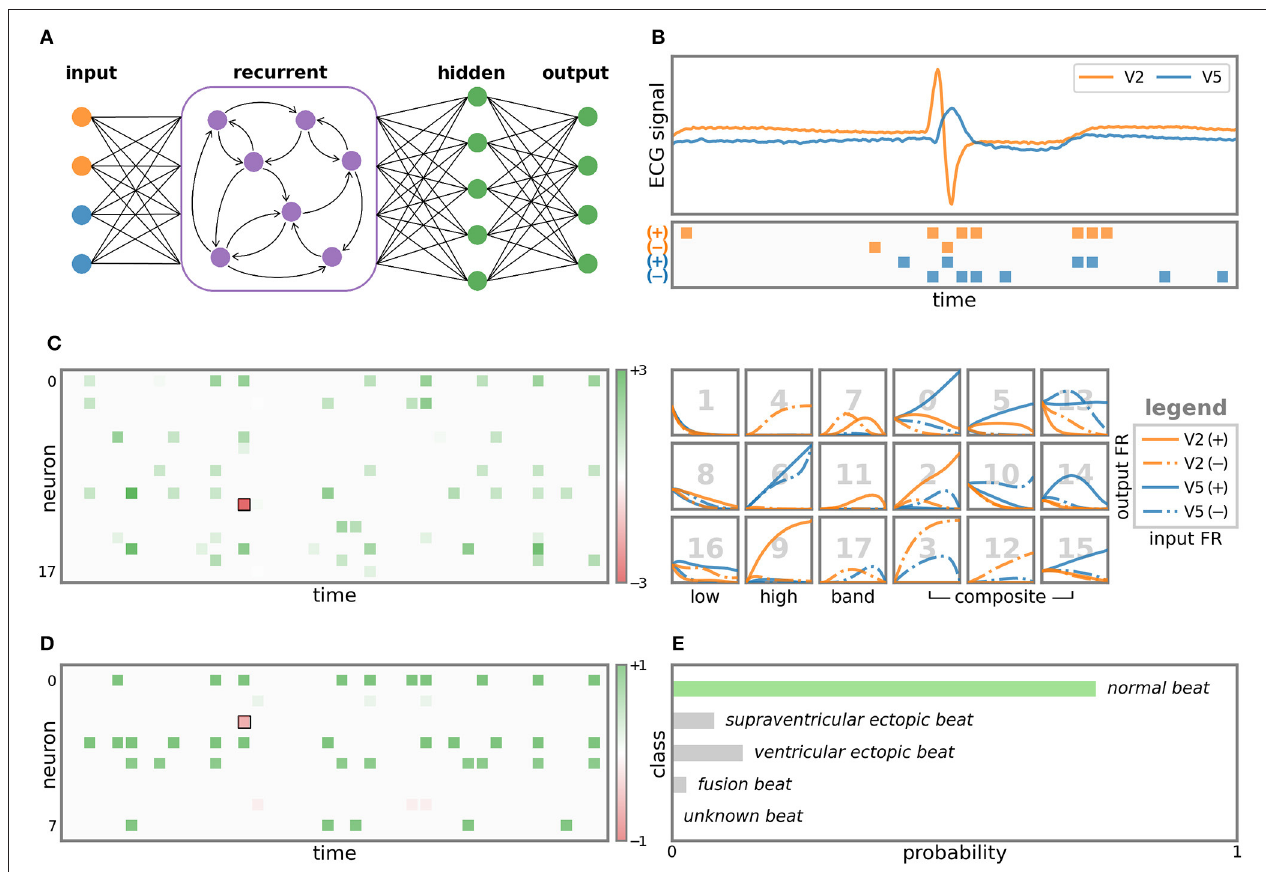
FIGURE 6 | Visualization of LC sampling and each layer of SNN. (A) The structure of the SNN model. (B) The ECG signal and the input spikes after LC sampling. (C) Output spikes and corresponding FR response curves of 18 neurons in the recurrent layer. The coordinates of the spikes represent the occurrence time and the neuron index. The color indicates the impact on the prediction result, where green is positive and red is negative. Response curves are plotted channel-by-channel. The x-axis and y-axis are the input and output FR, respectively. The 18 neurons are classified according to the filter effect, and the corresponding neuron index is marked in gray number. The output spikes of the hidden layer are drawn on (D) , and the predicted probability for the 5 ECG classes is shown on (E)